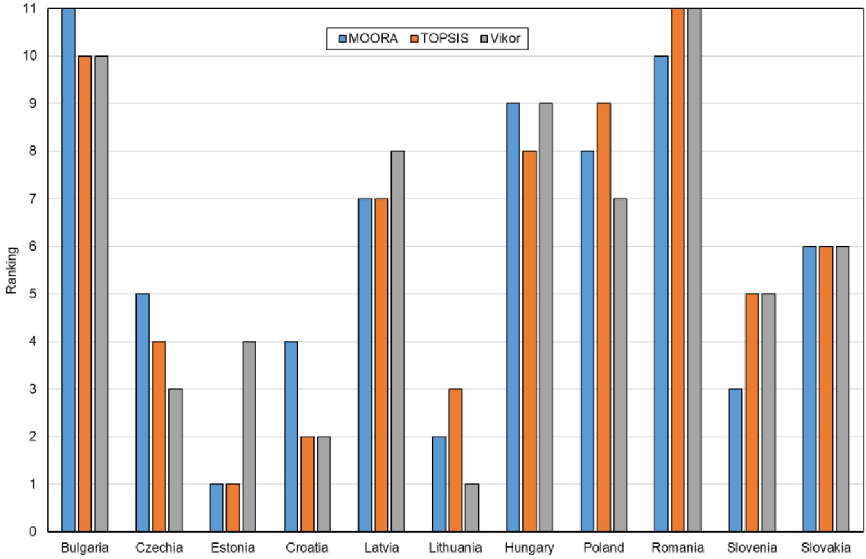
Fig 5. Classification (ranking) of the CEE countries in terms of digital maturity among all enterprises using the MOORA, TOPSIS and VIKOR methods.